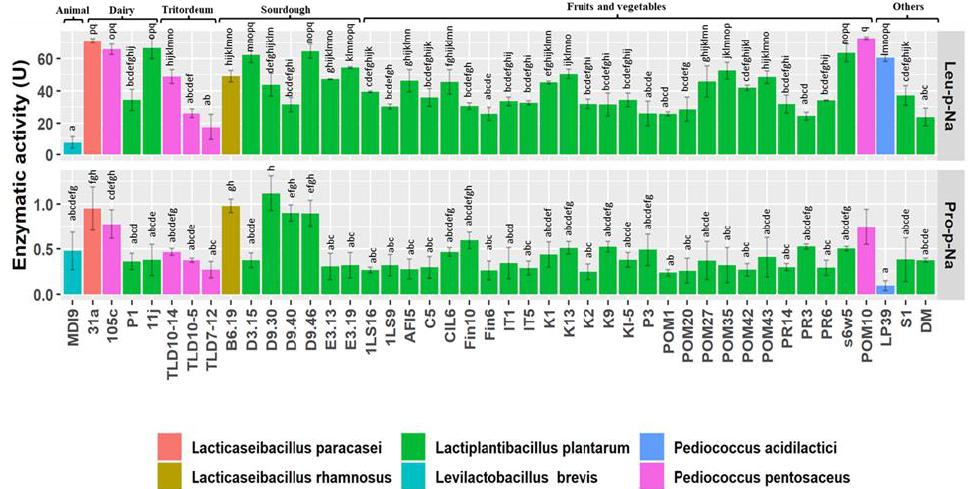
Figure 3. Peptidase activity (U) of 44 high-resistant lactic acid bacteria strains, belonging to different species and isolated from different sources, towards leucine- and proline p -nitroanilides. One unit (U) of activity was defined as the amount of enzyme required to liberate 1 µ mol of p -NA per min under the assay conditions. Data are expressed as the mean of three separate analyses ± standard deviations. Bars with different superscript letters differ significantly ( p < 0.05).